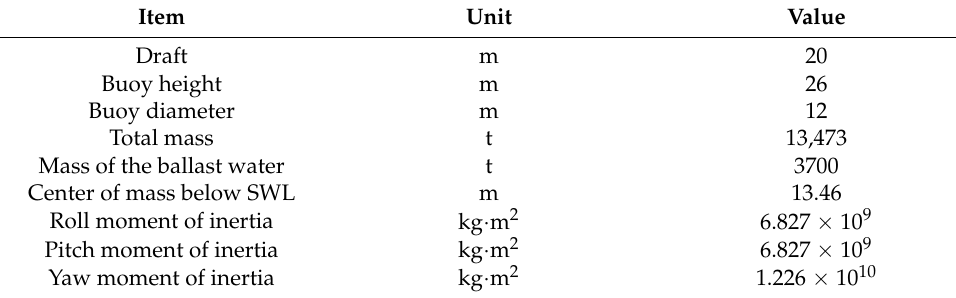
Table 2. Parameters of OC4-DeepCwind semi-submersible platform.